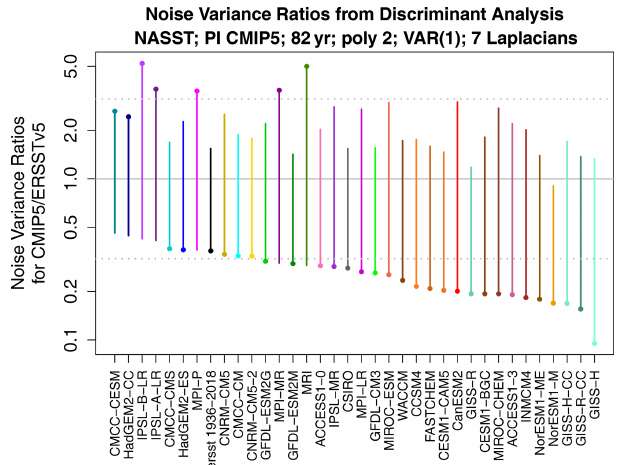
Figure 2. Range of noise variance ratios for maximizing the noise deviance D 1 : 2 between ERSSTv5 1854–1935 and 82-year segments from 36 CMIP5 pre-industrial control simulations. The horizontal dotted lines show the 2.5% and 97.5% significance thresholds un- der hypothesis H 1 . The dots identify the noise variance ratio that dominates the deviance (deviance measures the difference from one but does not distinguish between values greater than or less than